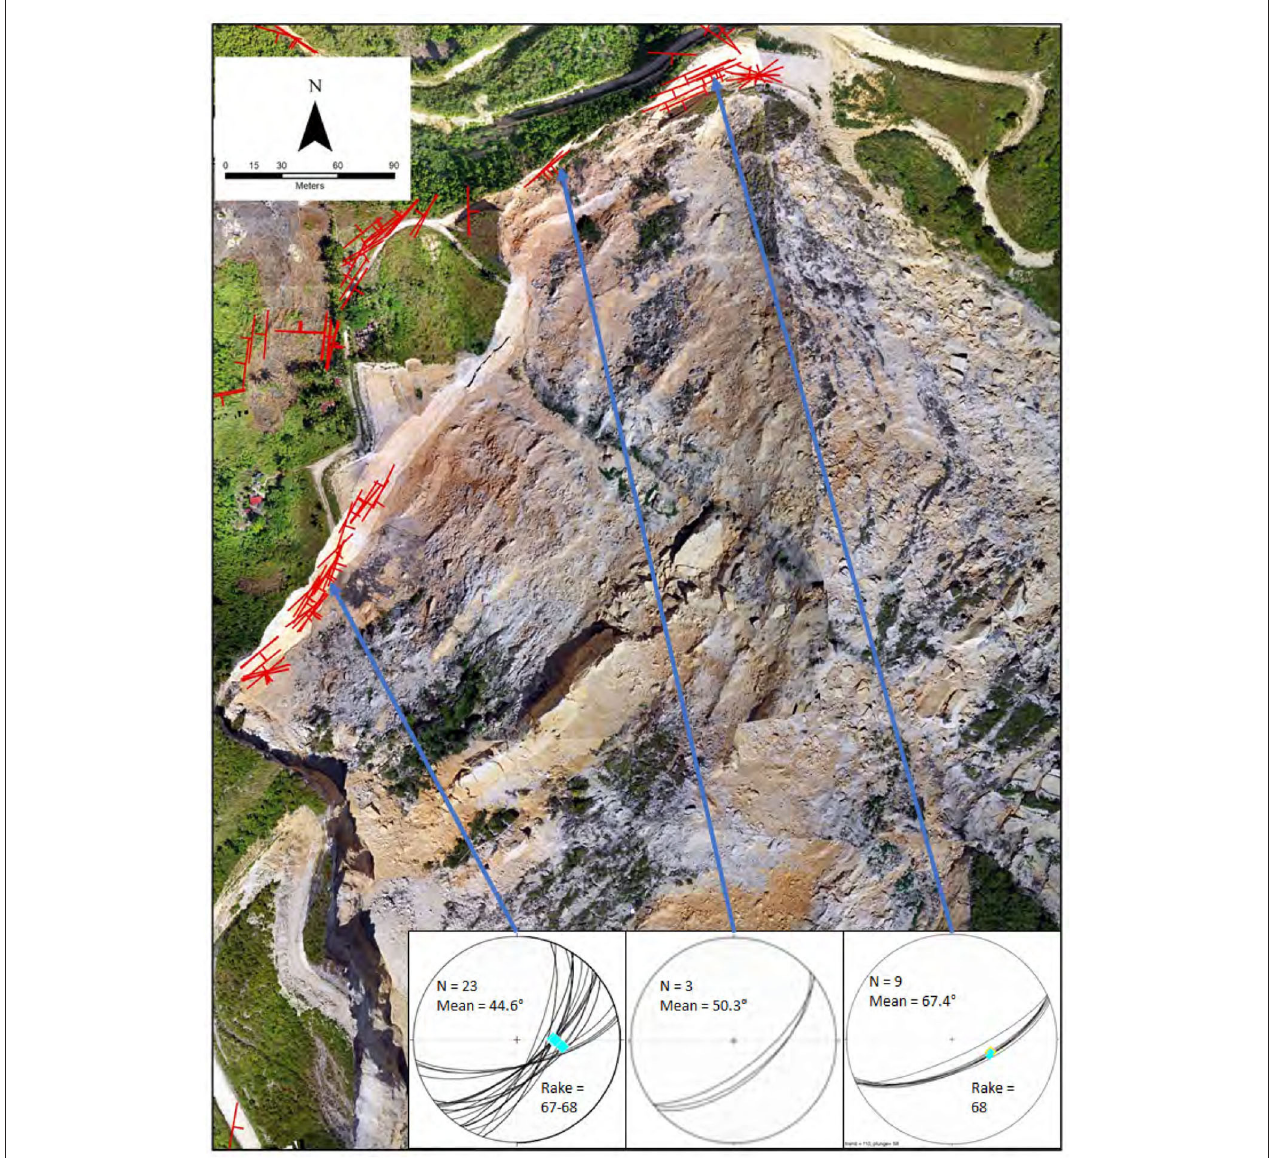
FIGURE 12 | Landslide head wall with fault measurements. The image is an orthomosaic map overlain on a DEM